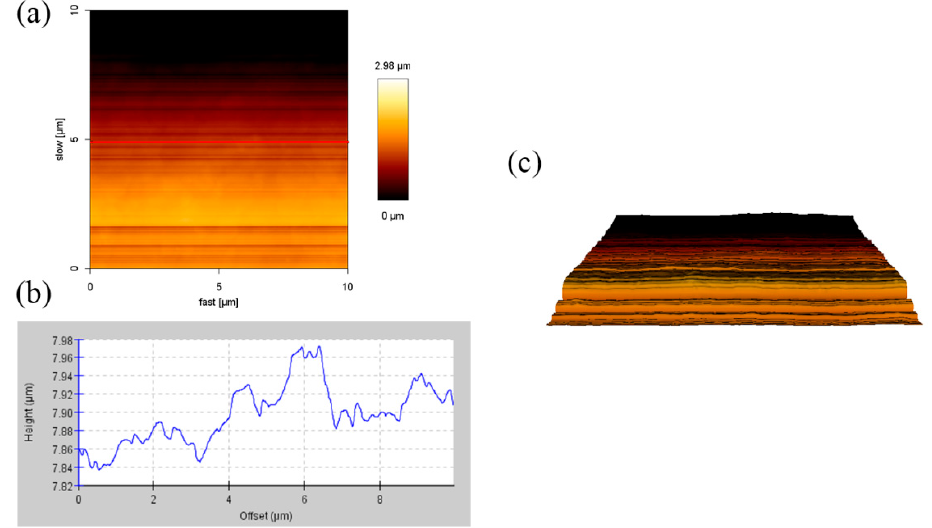
Figure 3. AFM images (10 × 10 µm) of the side of the treated silica of 1% SiO 2 double layer films: ( a ) A height image; ( b ) cross-section height profiles along the line in ( a ), and ( c ) a 3D reconstruction image.